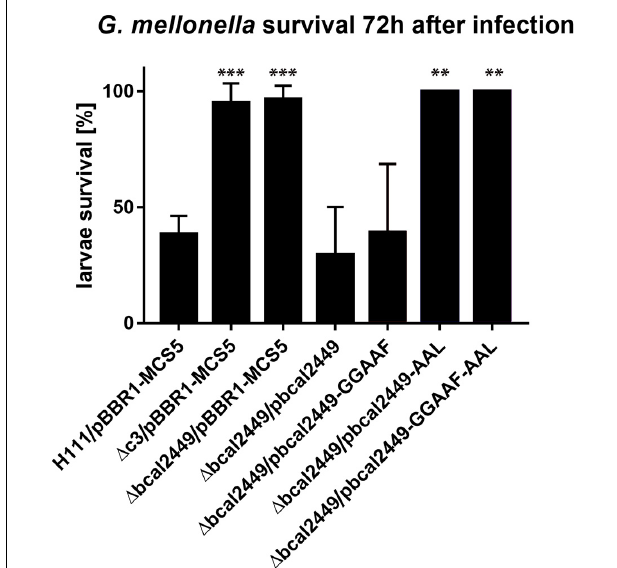
FIGURE 8 | Effect of mutations in the EAL and GGDEF domain of Bcal2449 on virulence of B. cenocepacia in G. mellonella . Ten larvae were infected with 10.000–20.000 B. cenocepacia wild type or mutants harboring pBBR1 plasmid derivatives as indicated, and larvae killing was observed over 3 days. Data presented here show mean and standard deviations of larvae survival of at least 3 independent experiments per strain and the corresponding wild type control 72 h after infection. Asterisks indicate P < 0.05 with unpaired t -test with wild type